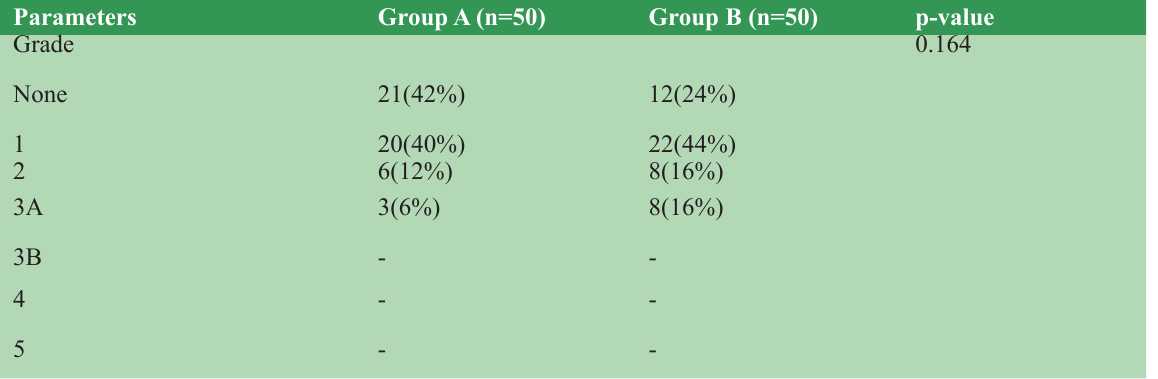
Table 4. Complications as per Modified Clavien Dindo